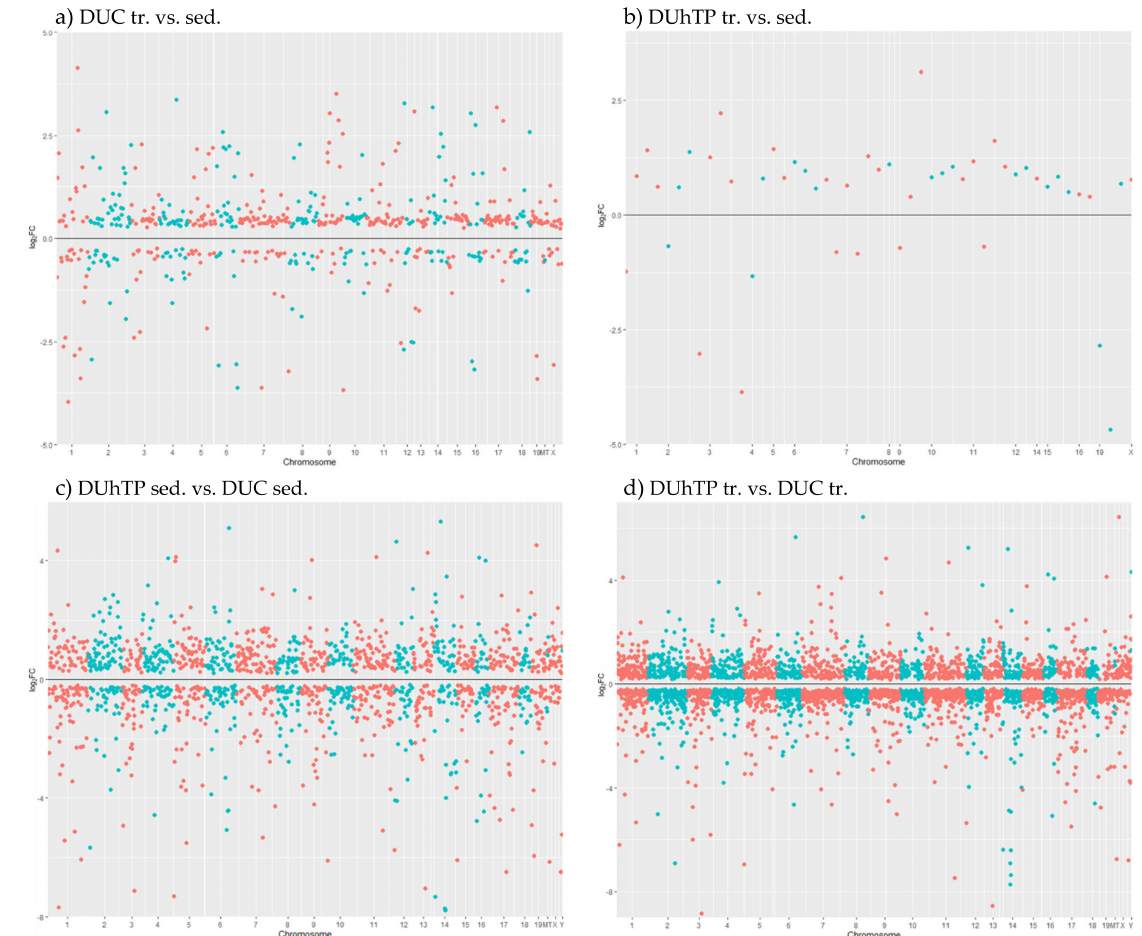
Figure 4. Mirrored Manhattan plots of the significant (FDR ≤ 0.05) differently expressed genes (DEGs) concerning the chromosome location in all comparison groups. Each point represents one gene in its genomic position. The chromosome numbers are reported in the x-axis, the level of expression in the y-axis as log2FC values. The maximum and minimum limits of the y-axis represent the range of log2FC values of each comparison. The gray line in the middle corresponds to log2FC = 0. All points visualized above the line belong to upregulated genes, while all the points visualized under the line are downregulated genes. The comparison groups are shown as ( a ) DUC tr. vs. sed., ( b ) DUhTP tr. vs. sed., ( c ) DUhTP sed. vs. DUC sed., and ( d ) DUhTP tr. vs. DUC tr. Abbreviation: sed. = sedentary, tr. = trained, vs. =